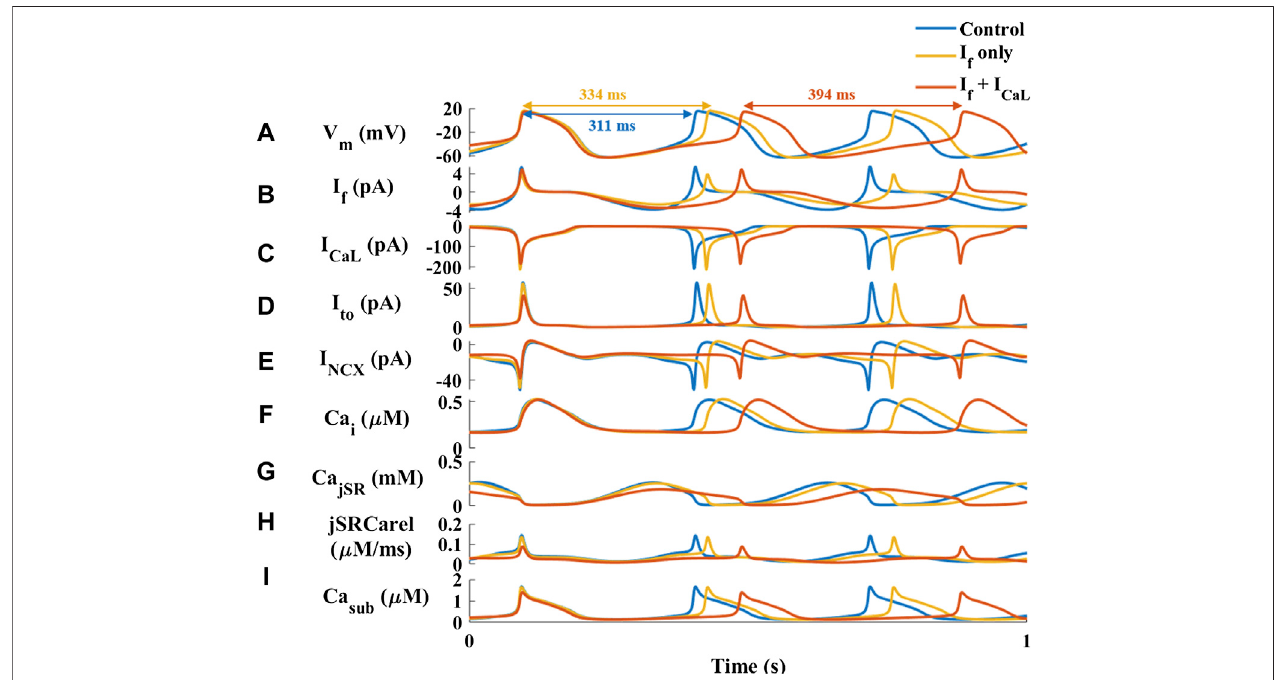
FIGURE 2 | Major currents and Ca 2+ cycling in simulated rabbit sinoatrial node cells in response to 1 µM hydroxychloroquine. Coupled-clock function of control (blue) the response to only decrease in HCN (funny) current (I f ) (red) and decrease in I f and L-type Ca 2+ current (I CaL ) (yellow). (A) Membrane voltage (V m ) and representativebeatintervals, (B) I f , (C) I CaL , (D) transientpotassiumcurrent(I t0 ), (E) Na + -Ca 2+ exchangercurrent(I NCX ), (F) intracellularCa 2+ concentration(Ca i ), (G) Ca 2+ concentration in the junctional SR compartment (Ca jSR ), (H) fl ux of Ca 2+ exiting the SR (j SRCarel ) and (I) Ca 2+ concentration in the subspace (Ca sub ).